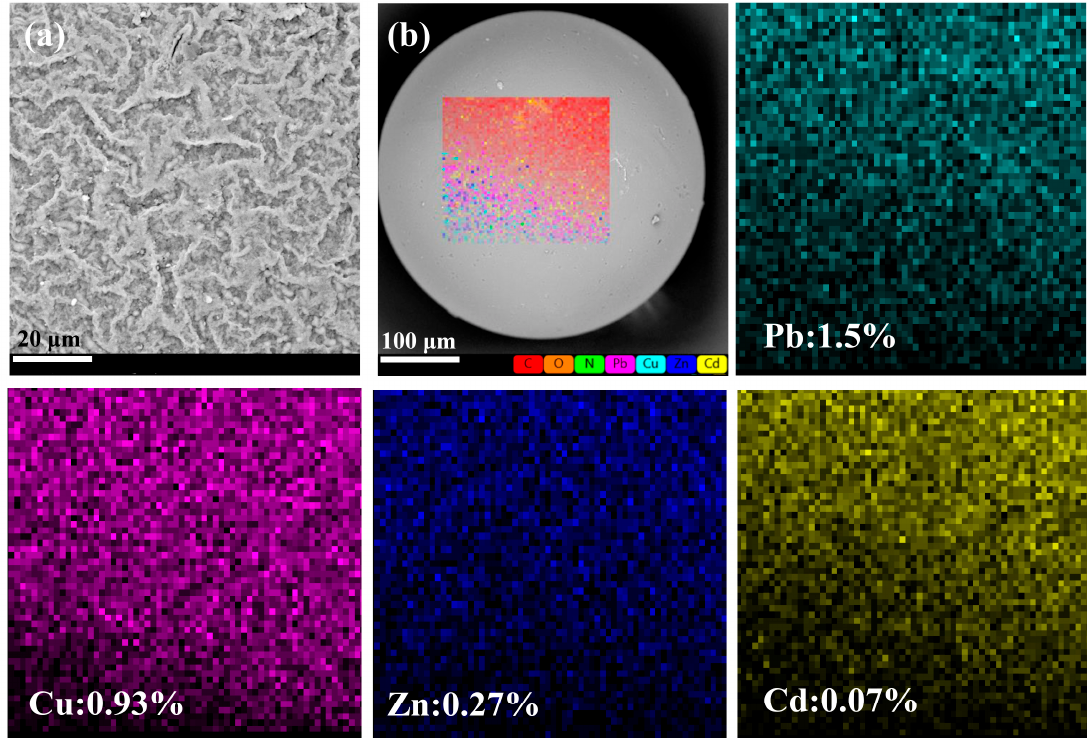
Figure 2. SEM image ( a ) and EDS result ( b ) of the WAC-resin-MIs.